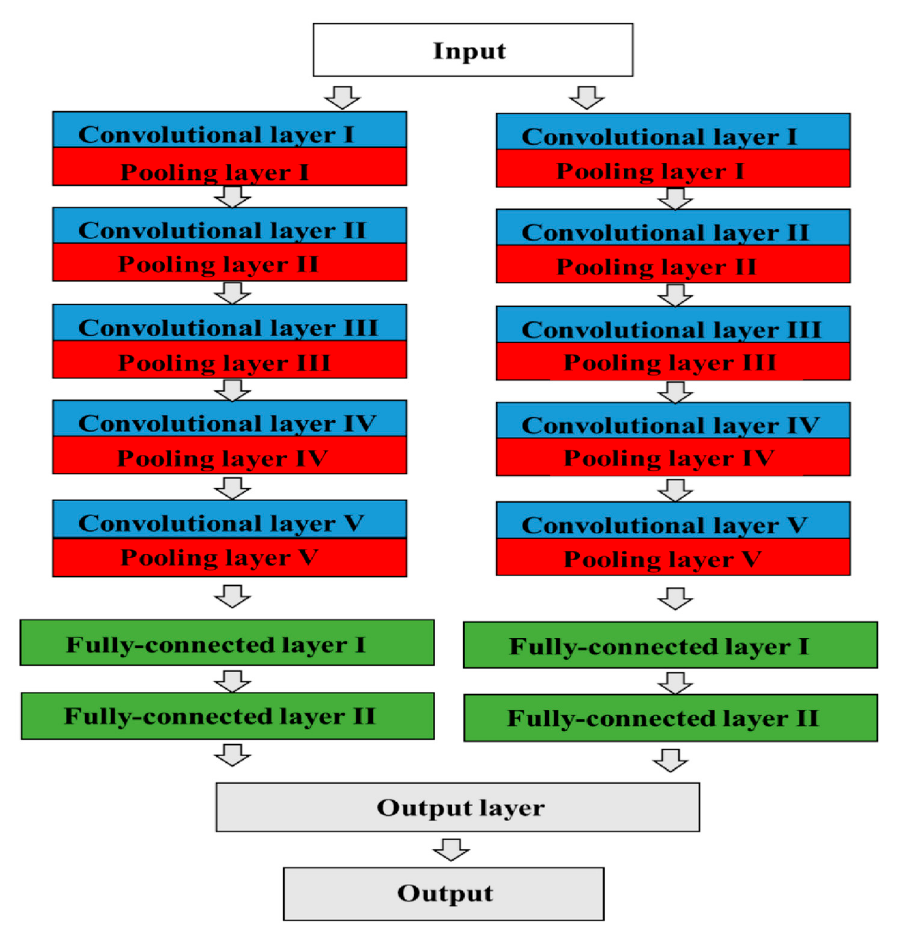
Figure 1. Architecture of a CNN model of AlexNet ( Front. Bioeng. Biotechnol. 2019 , 7 , 65. [57]).